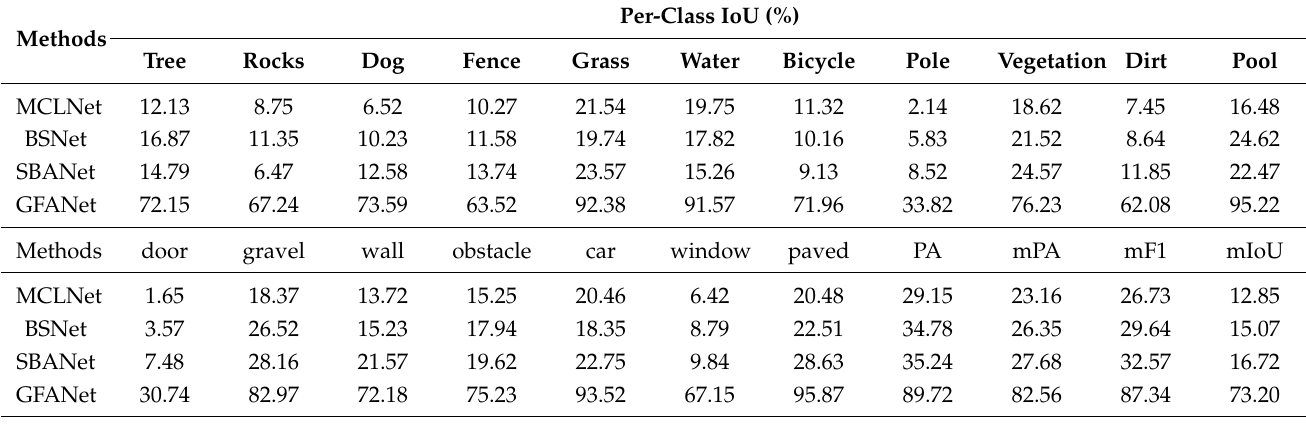
Table 4. Comparison of evaluation metrics on adversarial example test set in Semantic Drone dataset.